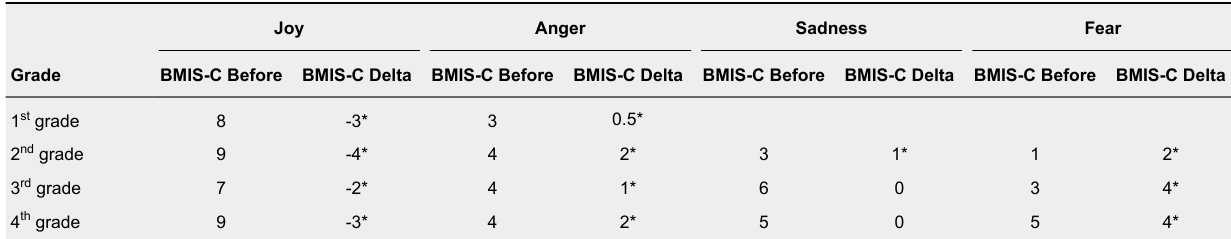
Evolution of the Emotional State Before and After Fear Induction, According to the Student’s Grade and the Induced Emotion Joy Anger Sadness Grade